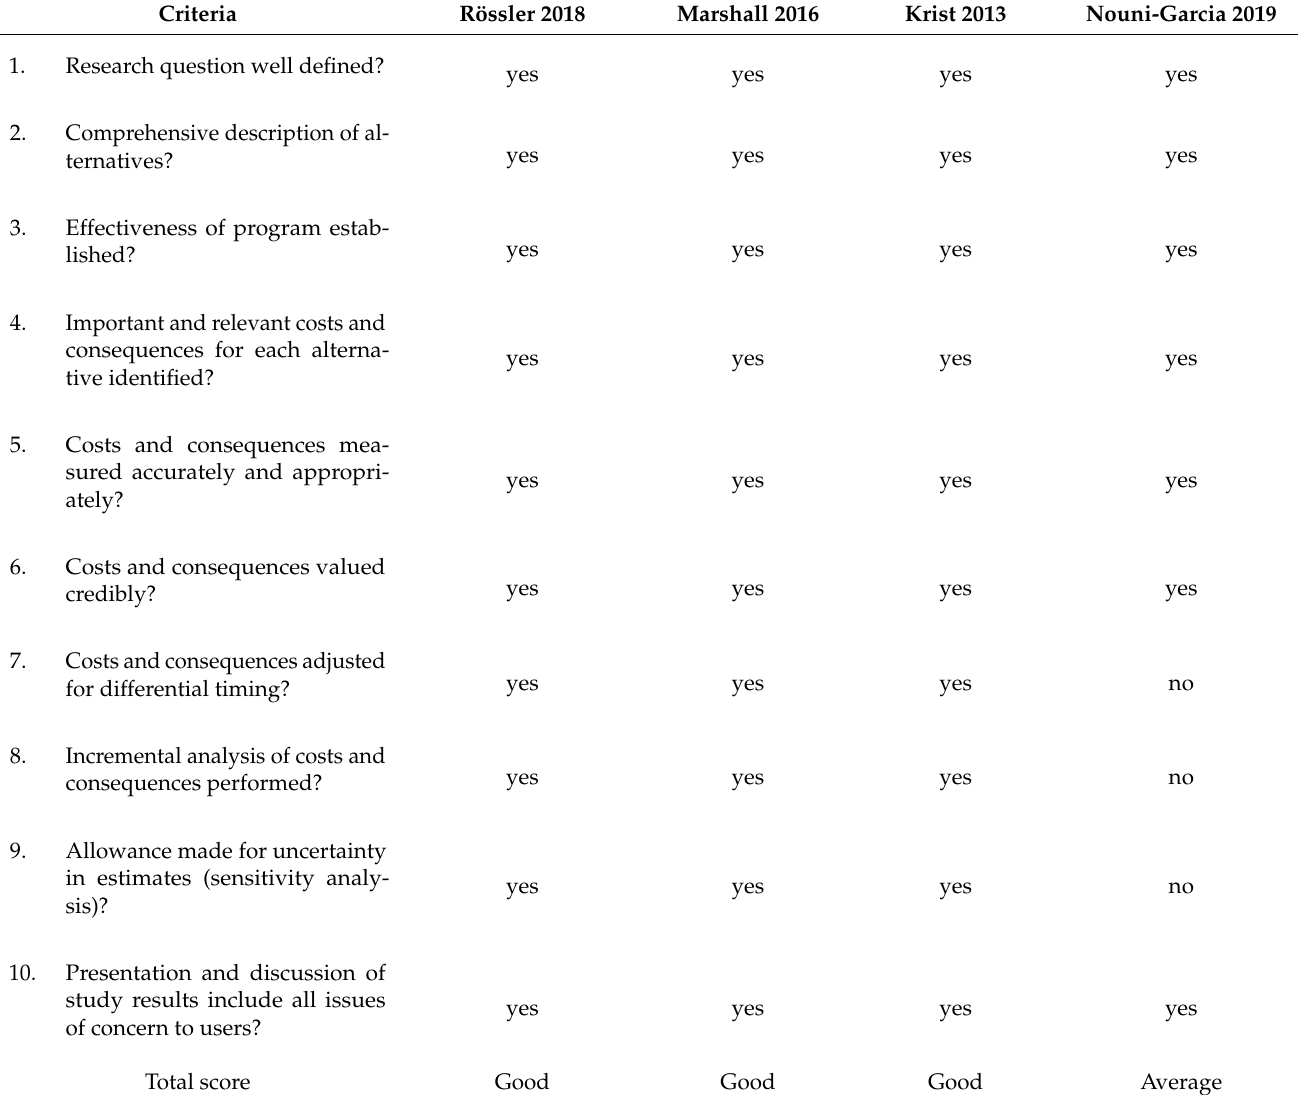
Table 3. Evaluation of economic criteria for evaluating study quality using the Drummond checklist.